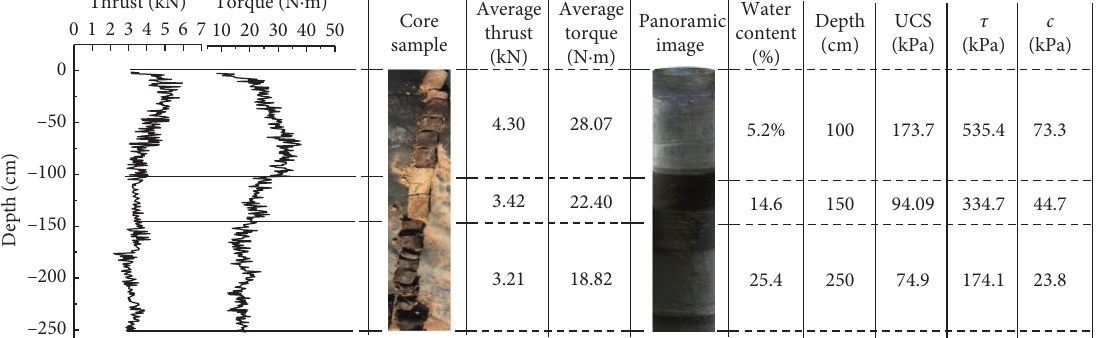
Figure 12: Comprehensive data of the rotary drilling test.